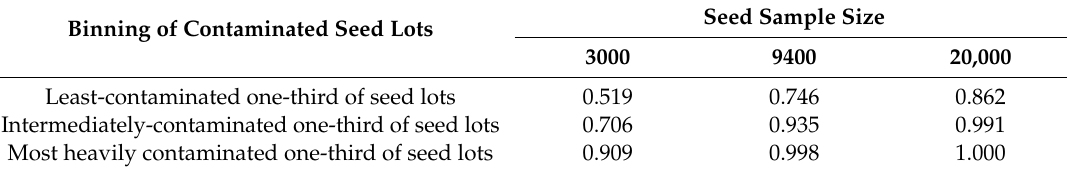
Table 1. E ff ect of seed sample size on average probabilities of detecting contaminated tomato seed lots within ranked bins across the observed viroid prevalence distribution. Each bin comprises one-third of the total of contaminated tomato seed